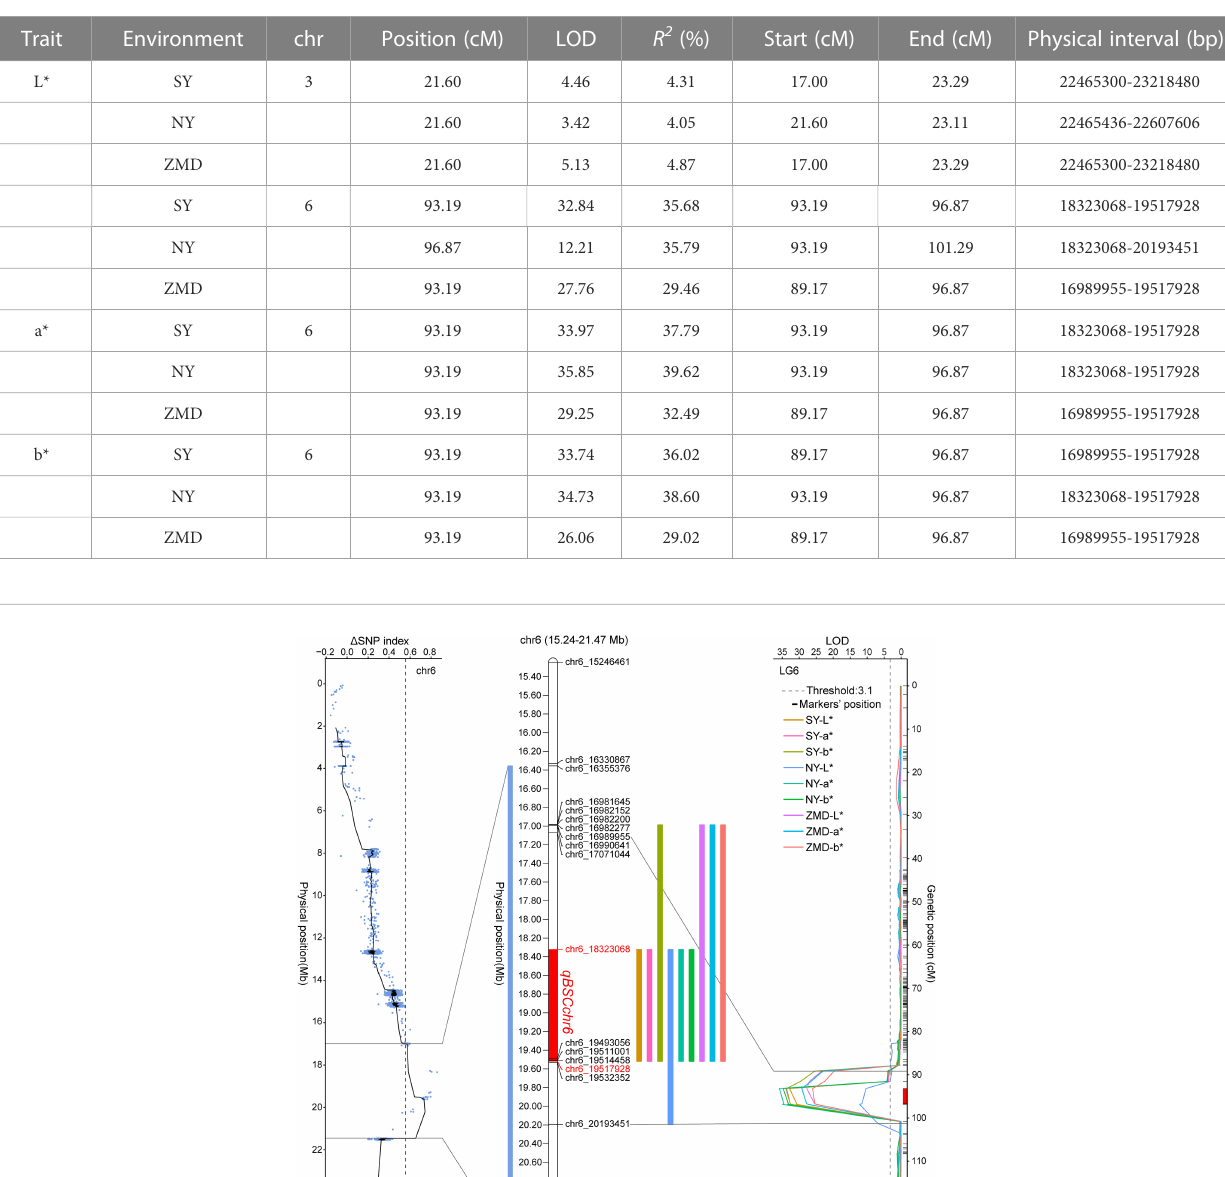
TABLE 3 QTL information for brown seed coat-related traits detected in the RIL population.